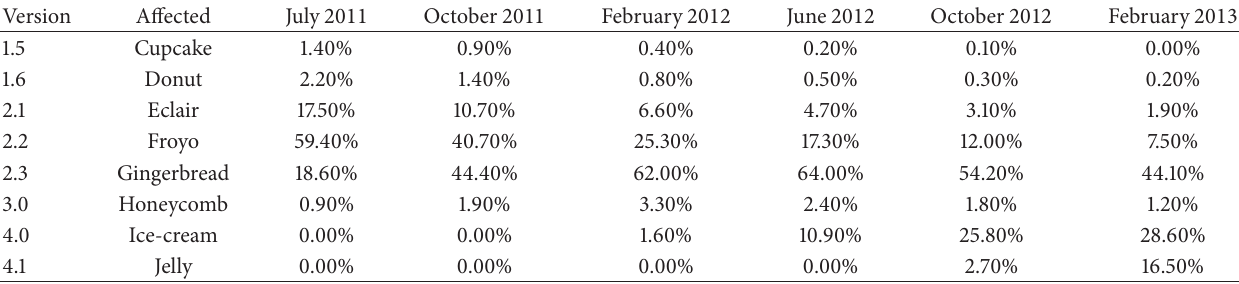
Table 7: Distribution of OS versions in Android smartphones from July 2011 until February 2013 [11].